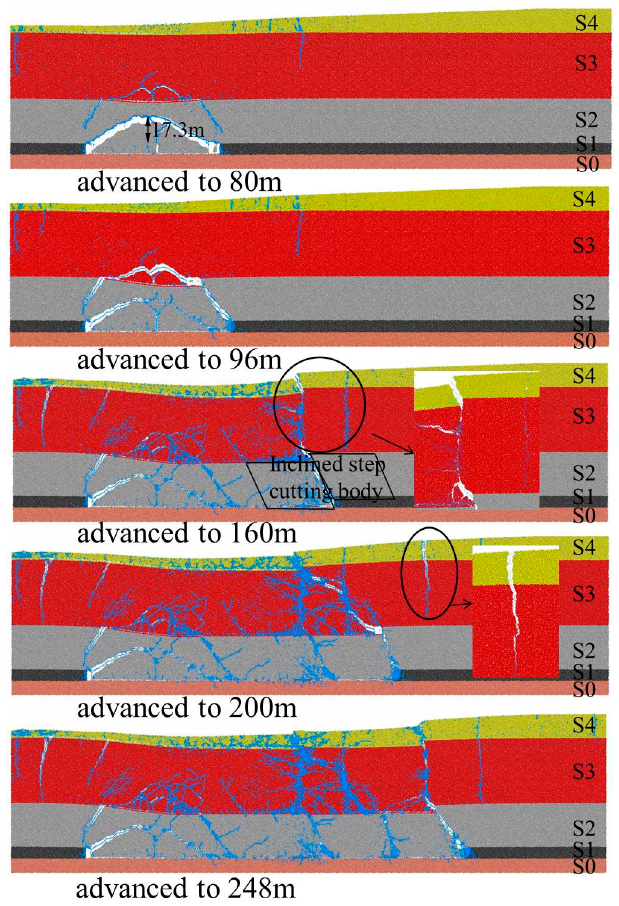
Figure 4. Rock caving patterns at different advancing distances.